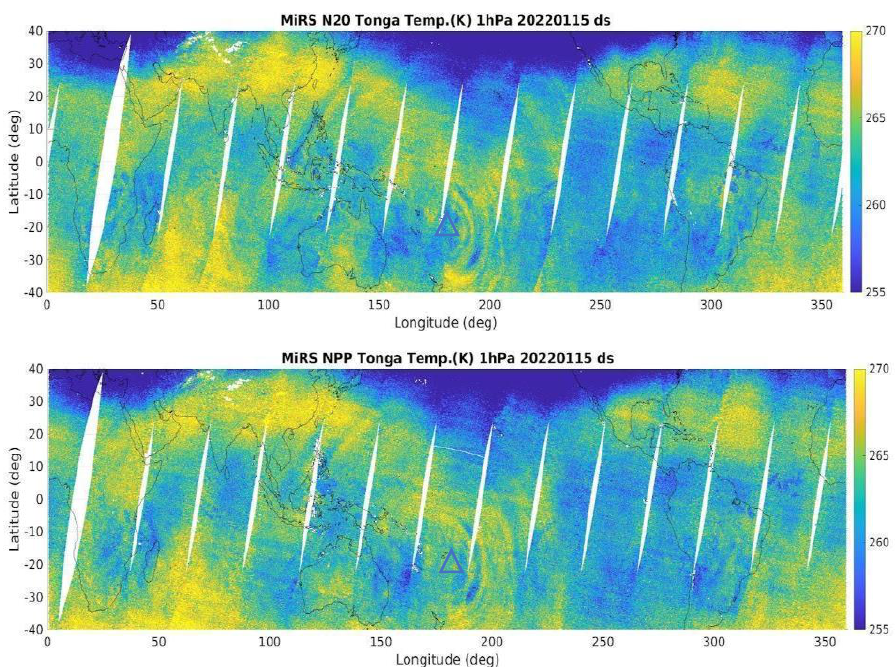
Figure 3. MiRS Retrieved Temperature from NOAA −20 (upper panel) and S−NPP (lower panel) at 1 hPa on 2022-01-15 at descending (ds) node.